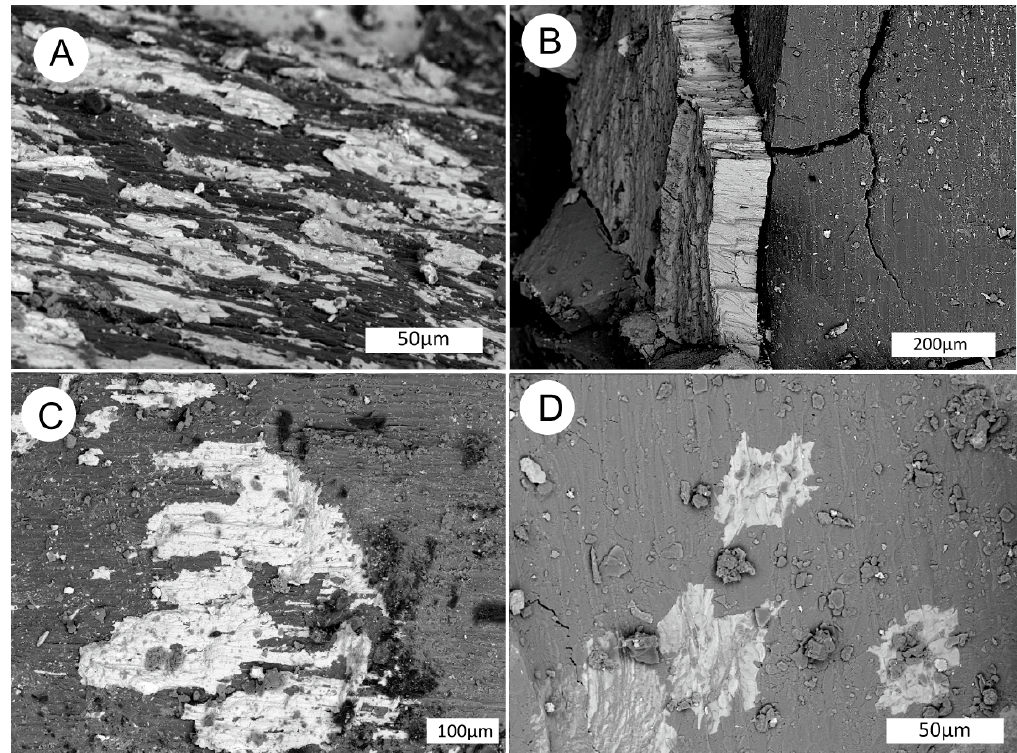
Figure 28. Moab (UT) specimen, SEM backscatter electron images. ( A ) Barite (light) occurring as a cell replacement for carbonized wood. ( B ) Barite filling fracture in carbonized wood. ( C ) Barite inclusion within carbonized wood. ( D ) Unidentified uranium mineral (light) within a calcite crystal in wood layer.